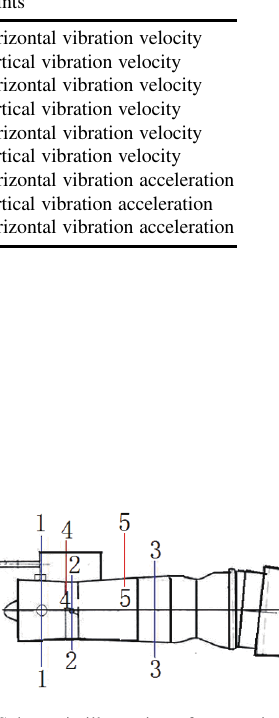
Fig. 2. Schematic illustration of aeroengine type